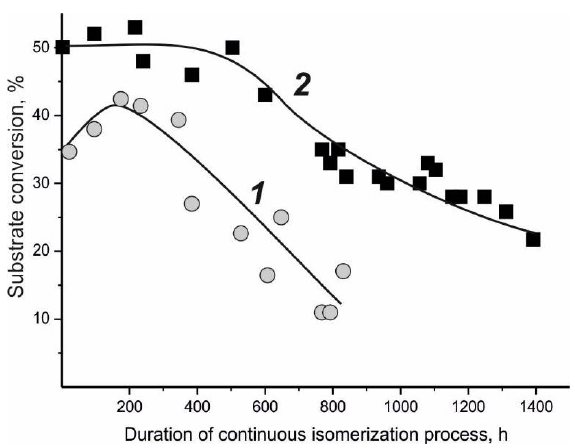
Figure 3. Dependence of substrate conversion at the outlet of column packed-bed reactor on the duration of continuous isomerization of fructose by the A. nicotianae ( 1 ) and r E. coli /xyl ( 2 ) whole-cell biocatalyst. Reaction conditions: 65 ◦ C, 3 M fructose, 0.02 M phosphate buffer pH 7.8 and 7.0 for A. nicotianae and r E. coli /xyl respectively, 1 mM Mg 2+ . Contact time was 5.5 h.